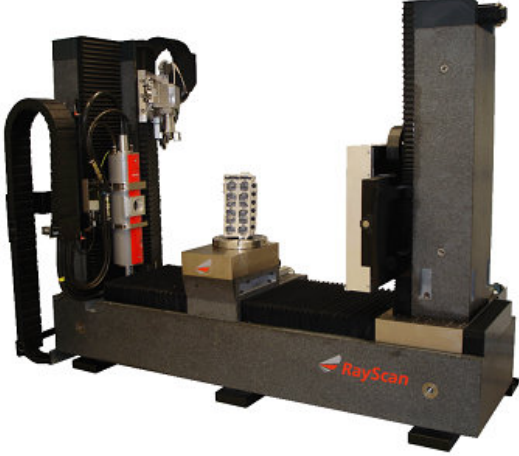
Figure 3. Image of the RayScan 250E system with dual sources on the left and flat panel detector on the right. An exemplary specimen is positioned on the rotary stage